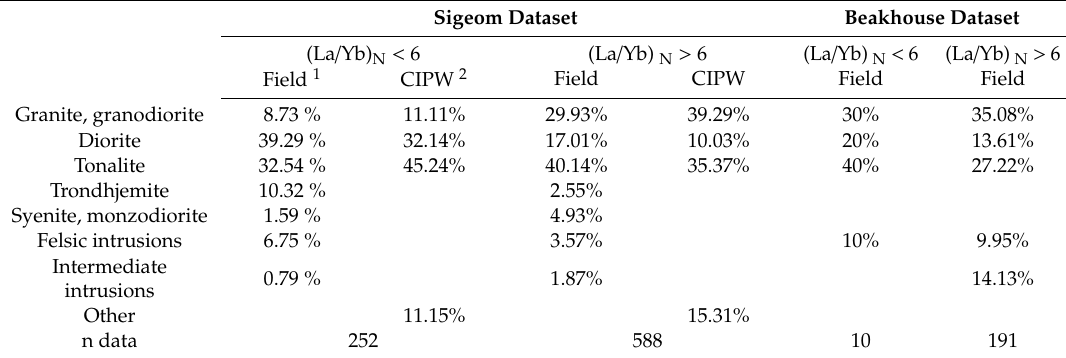
Figure 5. Chemical composition of intermediate-felsic intrusive rocks of the Sigeom dataset with (La/Yb) N > 6 ( n = 588). Rocks are displayed on ( a ) a primitive mantle-normalized [34] REE plot, ( b ) a primitive mantle-normalized [33] multi-element arachnid diagram modified from Pearce [35], ( c ) a binary plot of Mg number vs Zr/Ti, and ( d ) a Na 2 O-K 2 O-CaO ternary diagram (in wt%). For plots in ( a ) and ( b ), mean values are displayed as solid lines and the 25th, 50th (median) and 75th percentiles are displayed as dashed lines. Table 1. Rock types with fractionated ((La / Yb) N > 6) and less fractionated ((La / Yb) N < 6) REE